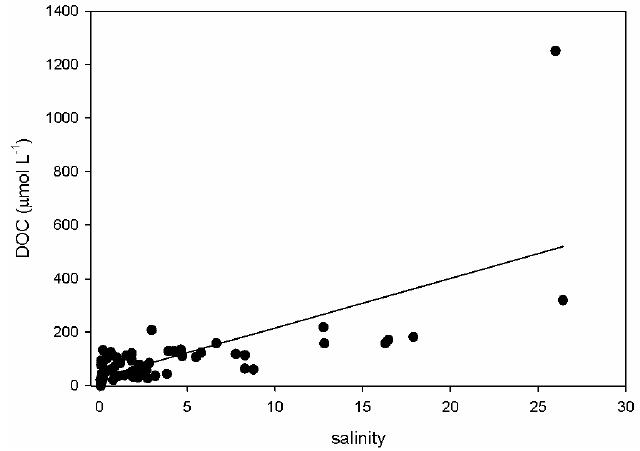
Figure A1. Cross plot of salinity vs. DOC concentration in all samples from SBH and PJH in 2011.